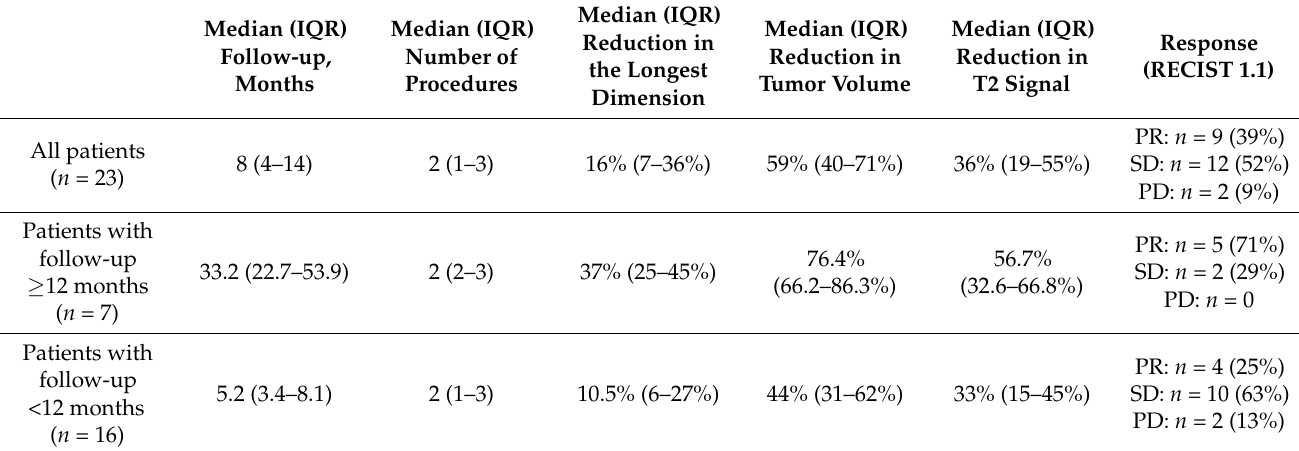
Table 2. Efficacy results overall and by duration of follow-up.